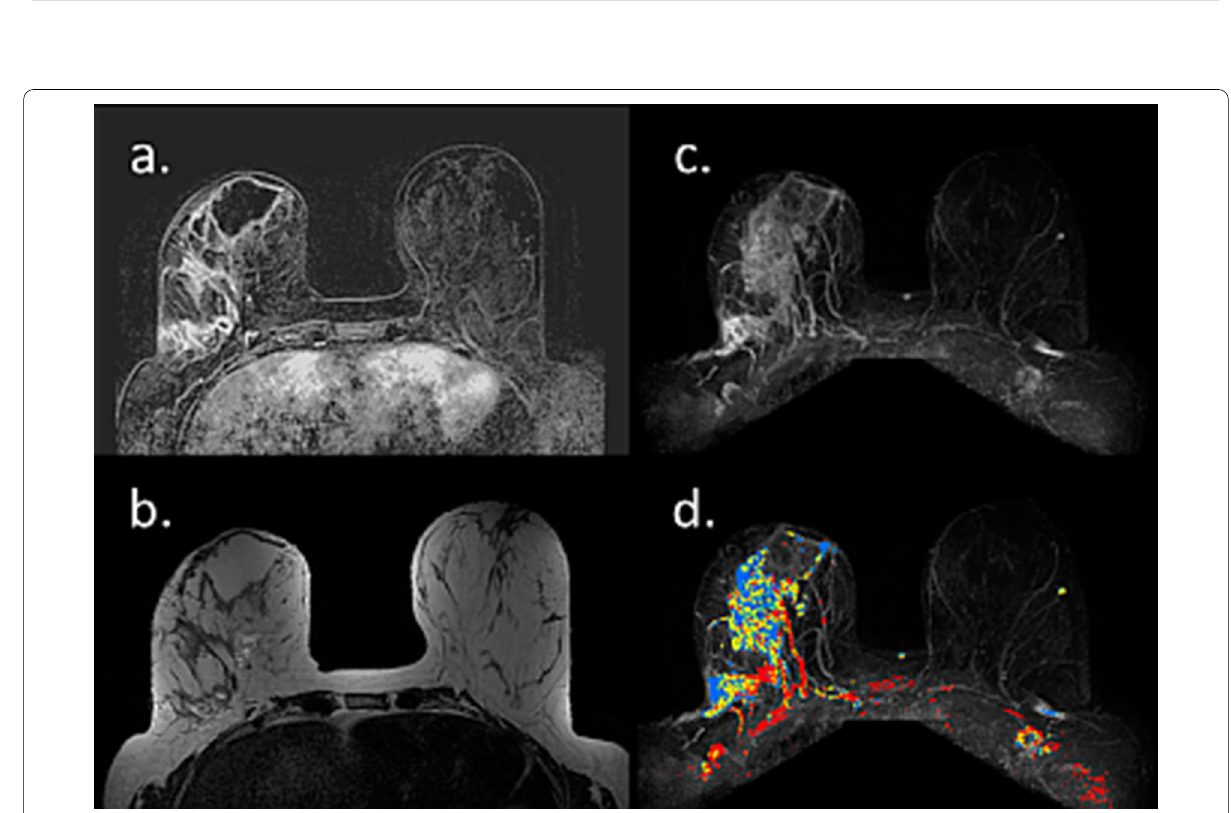
Fig. 9 Abscess. MRI of 31‑year‑old patient with a history of recurrent breast mastitis and abscesses during several separate lactation periods is presented, this time in aspiration‑confirmed breast abscess post weaning. Subtracted DCE ( a ) MIP ( c ) and CAD ( d ) reveal large rim enhancing regions with high T2 signal ( b ), compatible with an